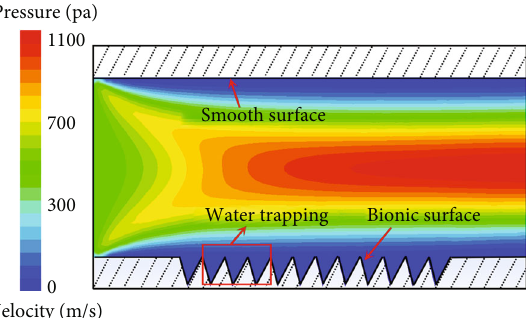
Figure 23: Simulated pressure distribution in turbulence [107].